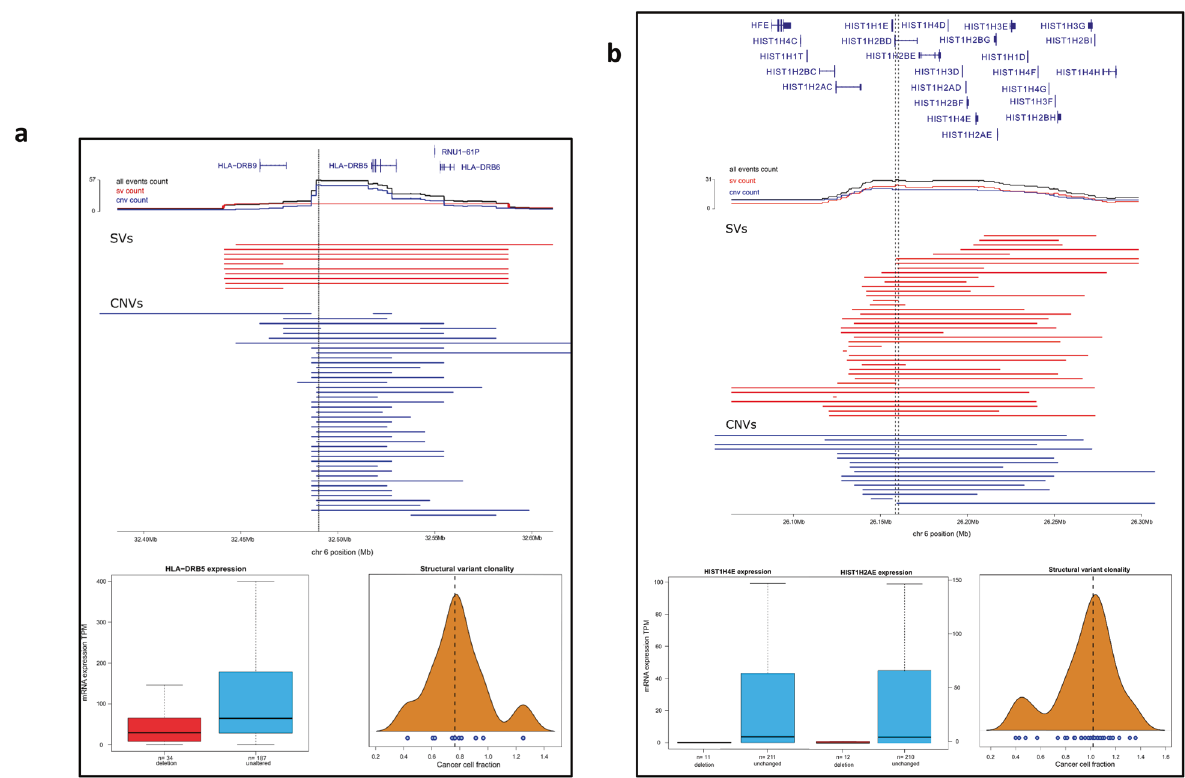
Fig. 3 Recurrent copy number and structural variants. Signi fi cantly ampli fi ed or deleted regions in CNV data, were fi ltered retaining only those with an enrichment of structural variants, based on a permutation test. Regional genetic plots showing recurrent deletions mapping to ( a ) HLA-DRB5 and ( b ) histone gene cluster 1. Upper panes shows gene position. Line plots show number of tumours with an overlapping variant; blue — CNVs, red — SVs, black — total count (tumours with both SVs and CNVs counted once). Central pane shows the individual variants. For convenience only variants starting or ending in the fi eld of view are plotted. Vertical black lines denote region with the highest deletion frequency. Lower left pane, box plots of gene expression split by mutational status. Lower right pane, density plots of structural variant clonality; blue circles individual SVs. Genomic coordinates from GRCh38.